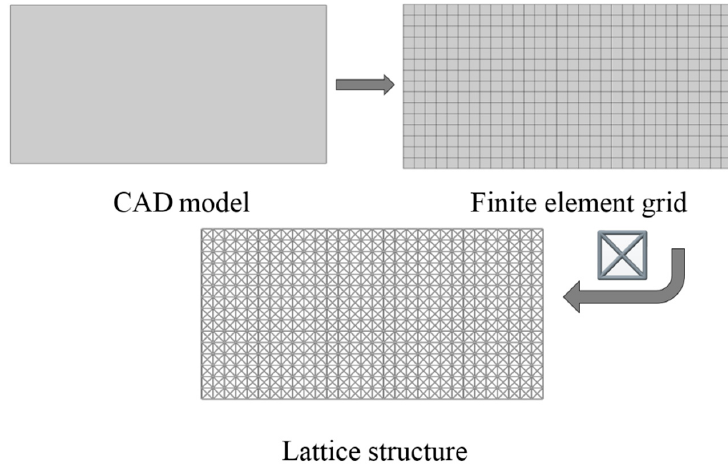
Figure 8. Illustrations of lattice structure generation for 2D cantilever beam.